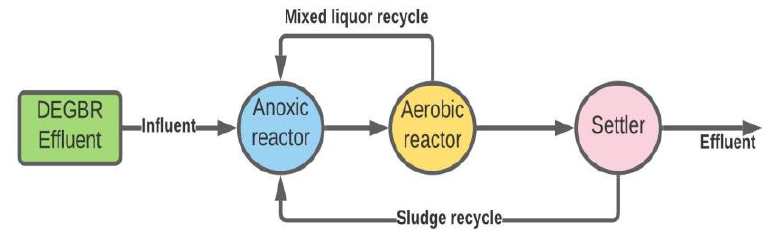
Figure 7. MLE system for nitrification and denitrification.